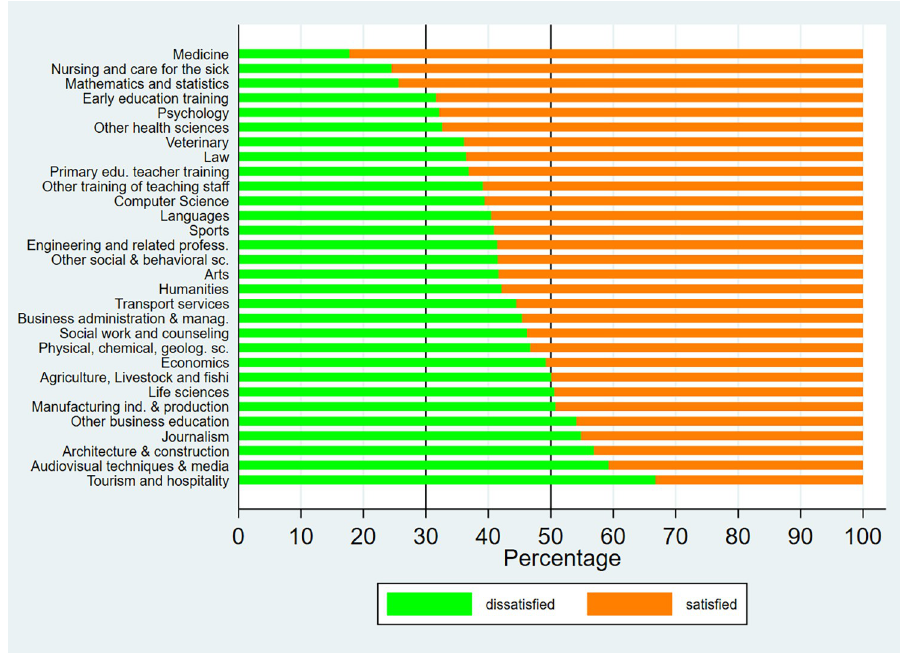
Fig 1. Satisfaction with university education by fields of study (Bachelor—2014). Source: University Graduate Job Placement Survey 2014 (INE). Own calculations.